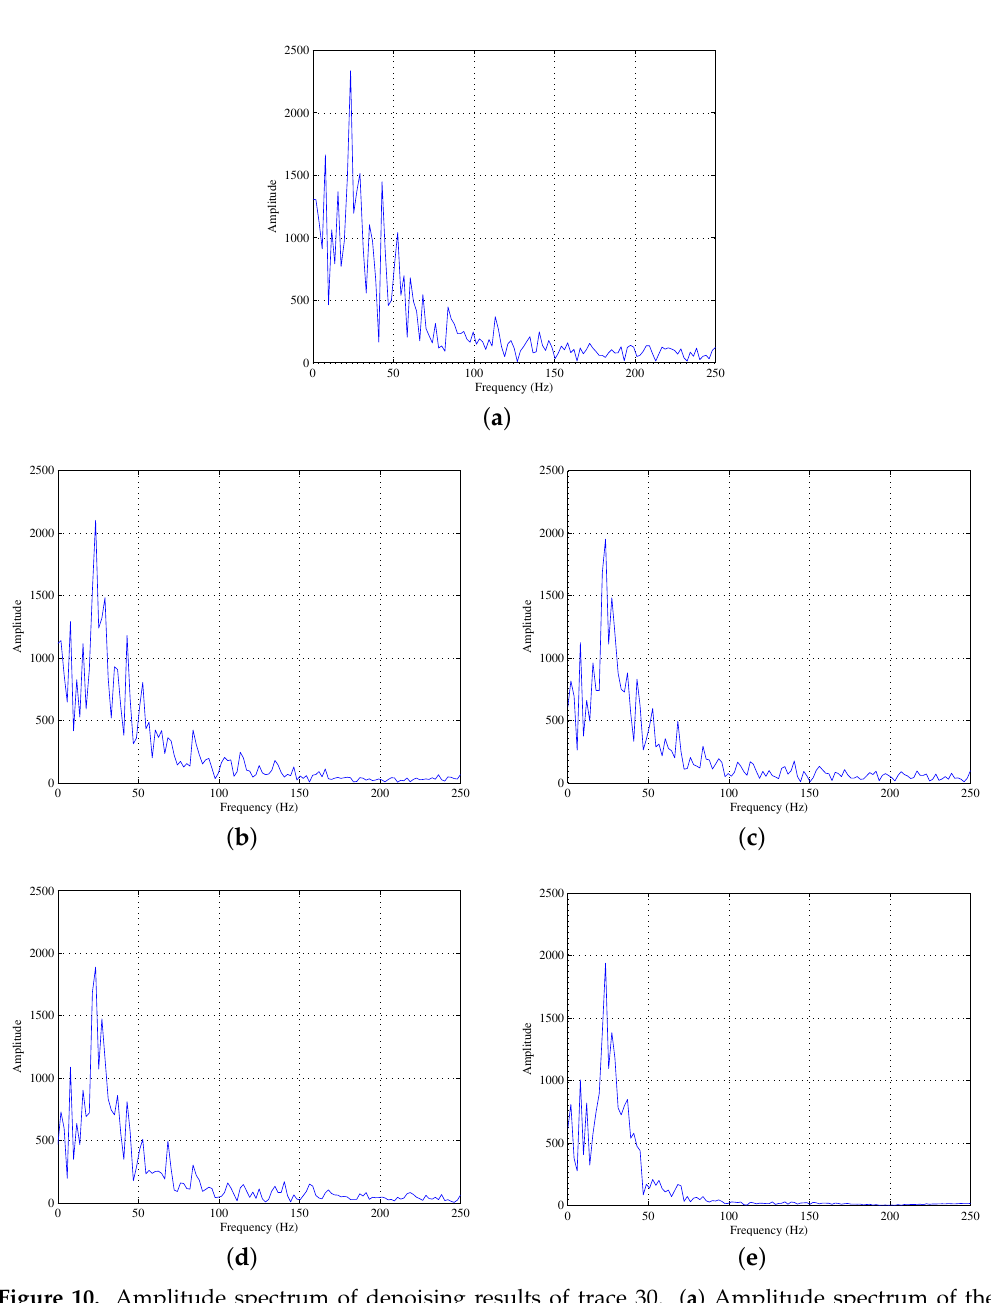
Figure 10. Amplitude spectrum of denoising results of trace 30. ( a ) Amplitude spectrum of the noise-free seiemic data, ( b ) amplitude spectrum of the wavelet denoising result, ( c ) amplitude spectrum of the ITVD result, ( d ) amplitude spectrum of the ATVD result and ( e ) amplitude spectrum of the denoising result by the SD-SpaLR